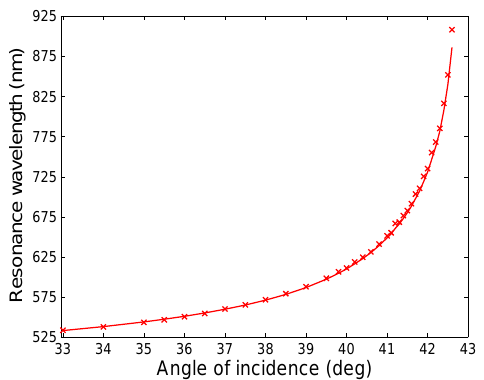
Figure 7. Measured (crosses) and modelled resonance wavelength as a function of the angle of incidence. Table 3. Parameters of dielectric function of Au retrieved from the